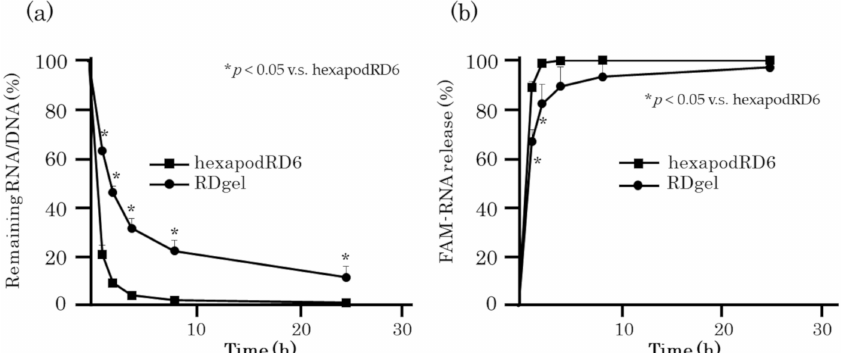
Figure 2. ORN-1 release from RDgel. ( a ) Time course of the amount of RNA / DNA remaining on the Transwell chamber after addition of 50 µ M of RNA / DNA. The amount of RNA / DNA after 1, 3, 6, 12, and 24 h after the addition of RNA / DNA was calculated by subtracting the released amount from the total amount. ( b ) Time course of FAM-ORN-1 release from hexapodRD6 or RDgel. Fluorescence intensity of PBS in the lower chamber was measured at 1, 3, 6, 12, and 24 h after starting the experiment. The results are expressed as the mean ± SD of three independent experiments, * p < 0.05 compared with